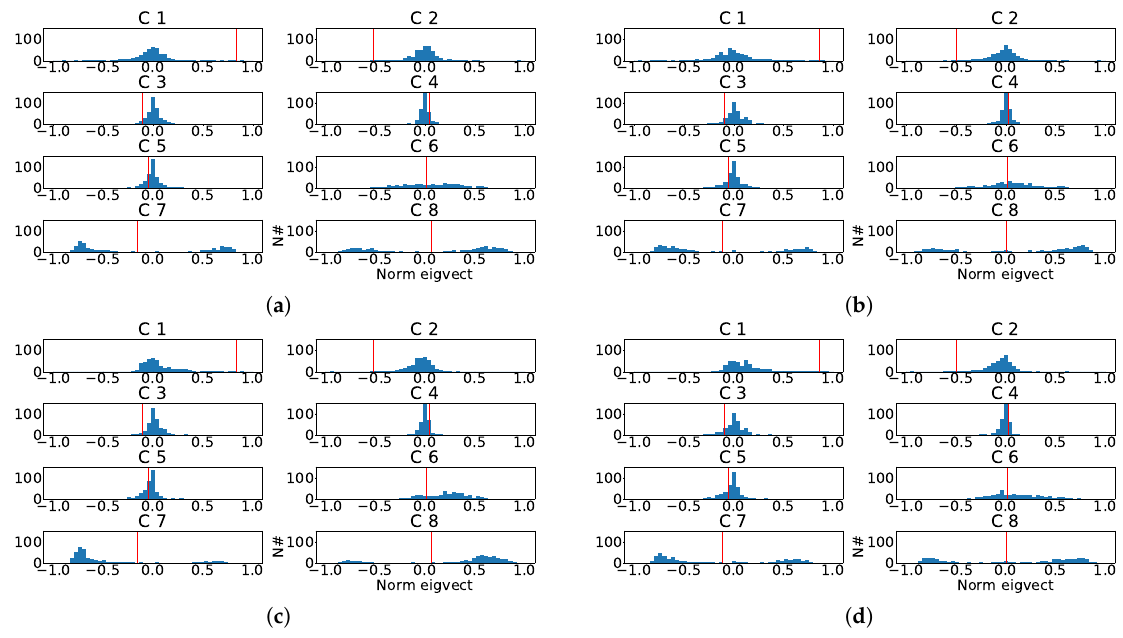
Figure 21. Distribution of the eigenvector components values for the last principal component of the eight independent lead model. ( a ) Distribution of the eigenvector components for each control patient. ( b ) Distribution of the eigenvector components for each subrogated fragmented patient. ( c ) Aligned distribution of eigenvector components for each control patient. ( d ) Aligned distribution of eigenvector components for each subrogated fragmented patient. The red line shows the value of transformation vector used in the